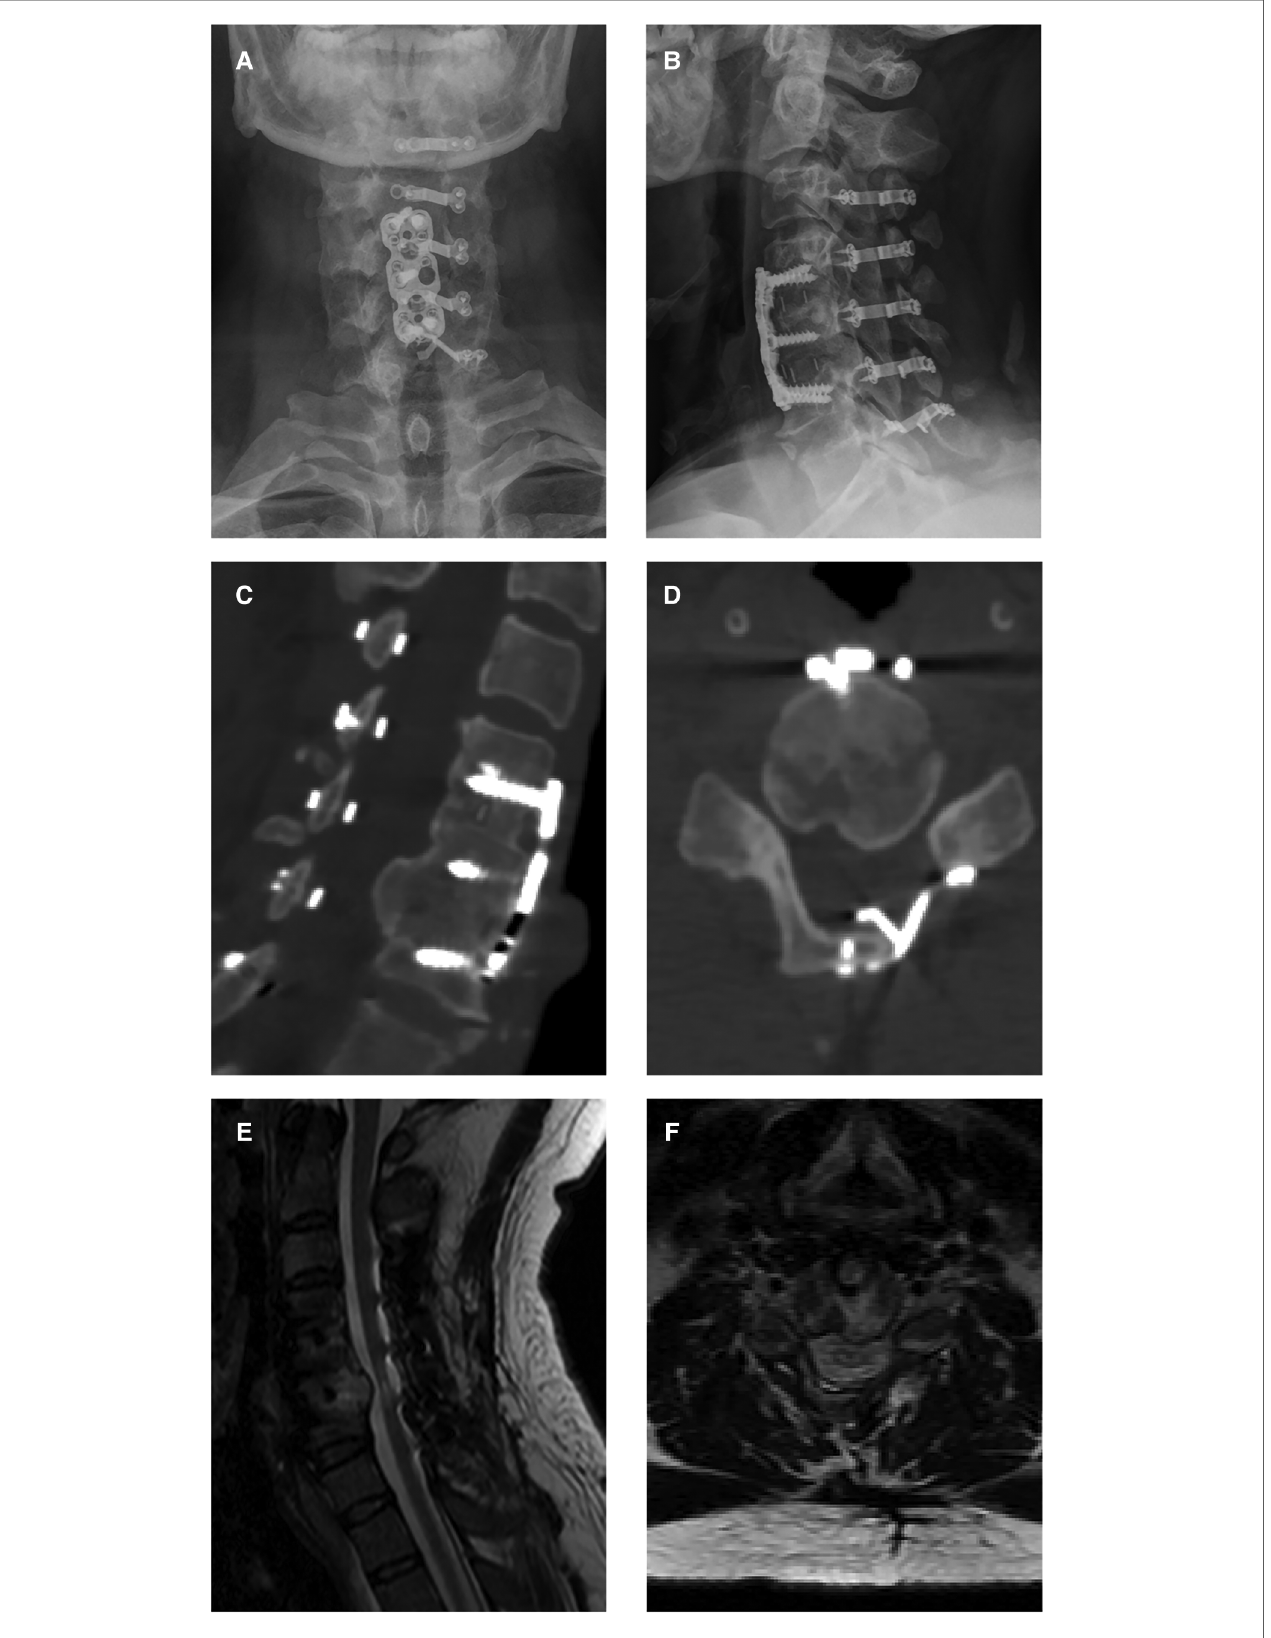
FIGURE 3 One-year follow-up images after open-door laminoplasty. ( A,B ) Postoperative x-ray images showing the accurate positions into which the plates and screws were installed. ( C,D ) Postoperative CT images showing direct adherence of all plates to the host bone, creating a new, wide canal space. ( E,F ) Postoperative MRI images showing decompression of the spinal cord at the C5/6